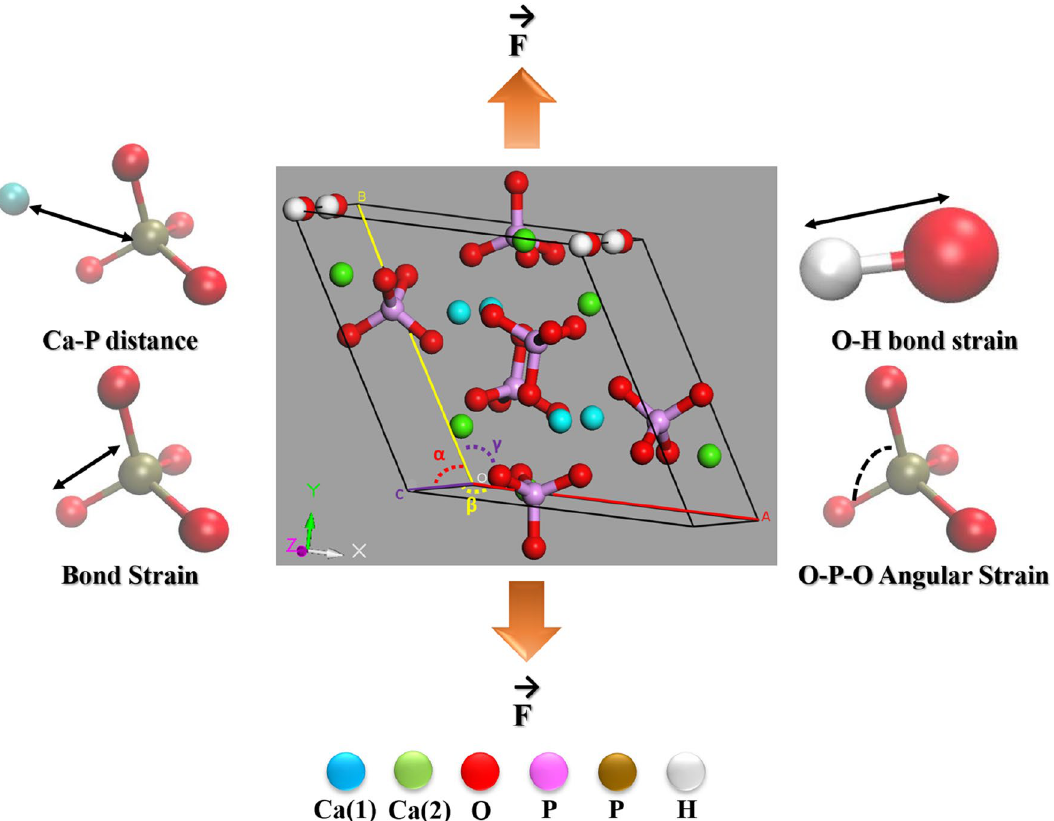
Figure 1. Schematic illustration of different aspects of the covalent/ionic bond framework during tensile loading, as analyzed using MD simulation. The unit cell of undoped hydroxyapatite (HA), with minimum energy configuration is obtained using Materials Studio 6.0. The crystallographic parameters are shown with colour code: a, α: red, b, β: yellow, c, γ: